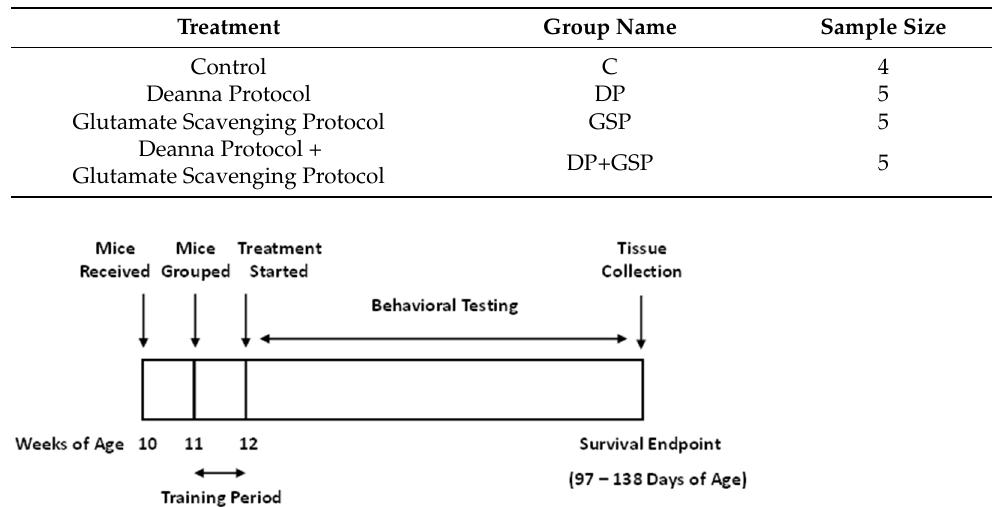
Figure 1. Time course of serum GOT levels. Serum was taken at various time intervals following intraperitoneal injections of 5.3 units glutamic oxaloacetate transaminase (GOT) into B6SJLF1/J mice (n = 3 or 4) (Jax Labs stock # 100012). After reaching an apparent maximum at 6 h, elimination occurred with a decay rate of 102.5 h with a T1/2 of 18 h. Data points indicate mean +/ − SEM. Table 1. Experimental treatment groups.